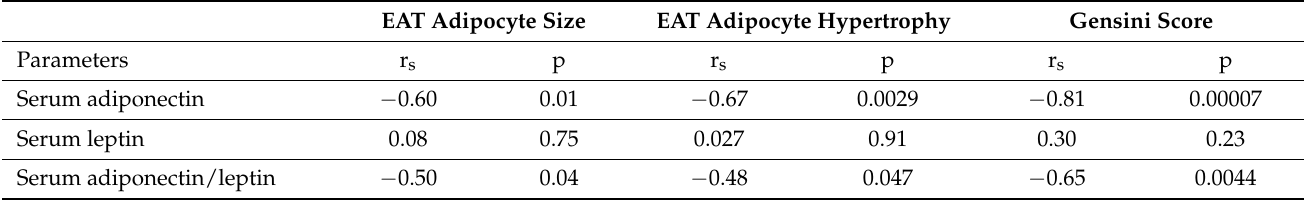
Table 7. Correlation between serum adiponectin, leptin, EAT adipocyte size, EAT adipocyte hypertrophy, and Gensini score. EAT Adipocyte Size EAT Adipocyte Hypertrophy Gensini